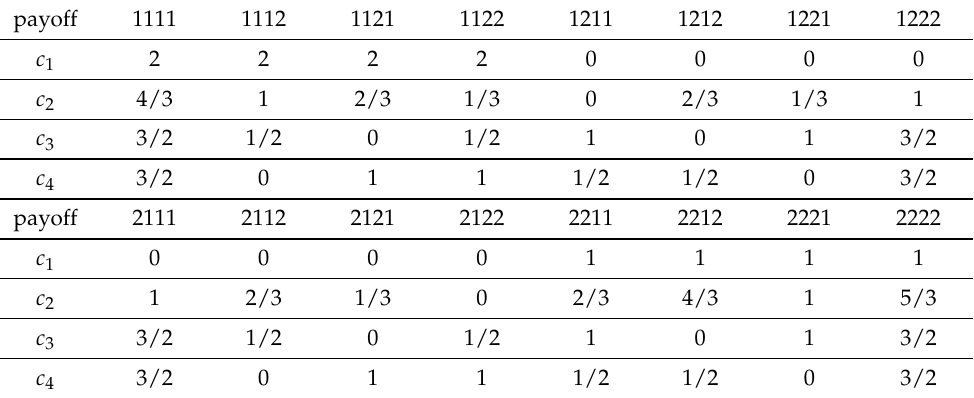
Table 2. From payoffs to